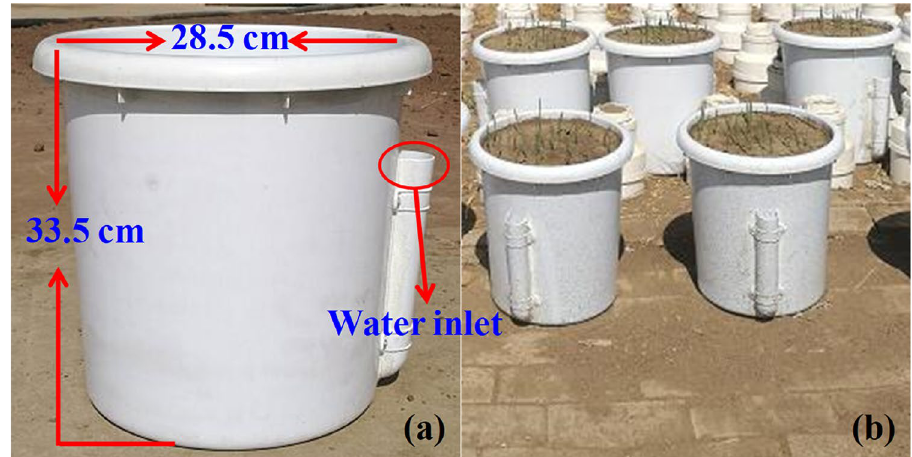
Figure 2. The plastic pots used in the experiment ( a ) and the pots planted with naked oat ( b